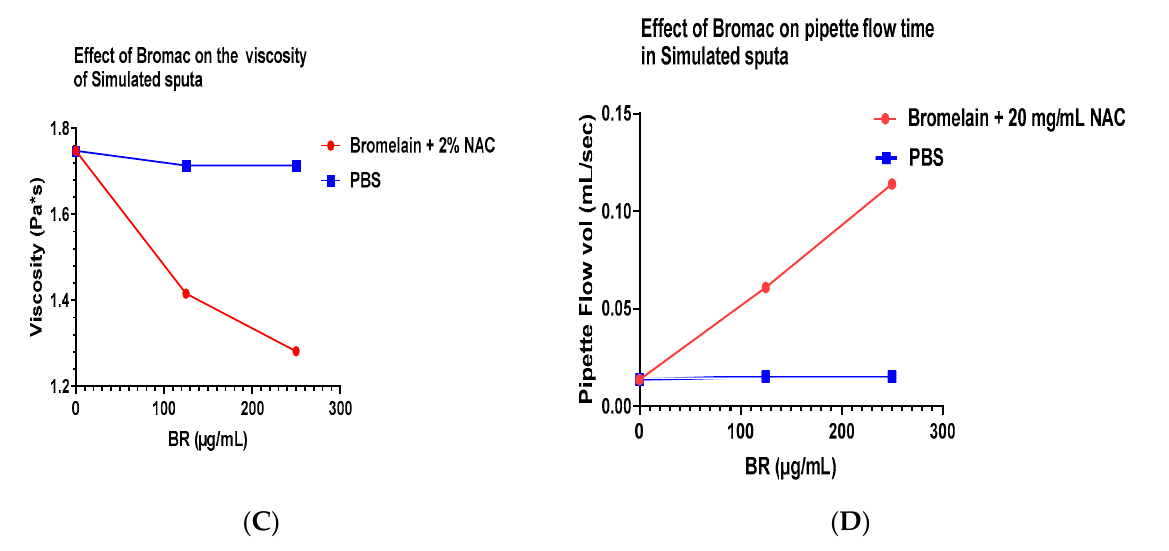
Figure 4. ( A ) In artificial sputa (AS), there was a noticeable drop in viscosity after treatment with BromAc (bromelain 125 and 250 µg/mL + NAC 20 mg/mL). ( B ) In AS, the flow rate increased with the addition of BromAc. ( C ) In simulated sputa (SS,) there was a considerable drop in viscosity with the addition of 125 or 250 µg/mL bromelain + NAC 20 mg/mL. ( D ) In SS, there was almost a linear increase in flow rate (pipette emptying time) with the addition of increasing amounts of bromelain and 20 mg/mL NAC. Table 4. The effect of aerosolized BromAc (bromelain (BR) 125 or 250 µg/mL + NAC 20 mg/mL) on both artificial (AS) and simulated sputa (SS) using two parametric measurements such as viscosity ( γ ) and pipette flow time ( ε ). Data presented as mean ± SD. Test samples were compared with con- trol after treatment for significance testing; * = p < 0.05; ↓ = decrease; ↑ = increase.